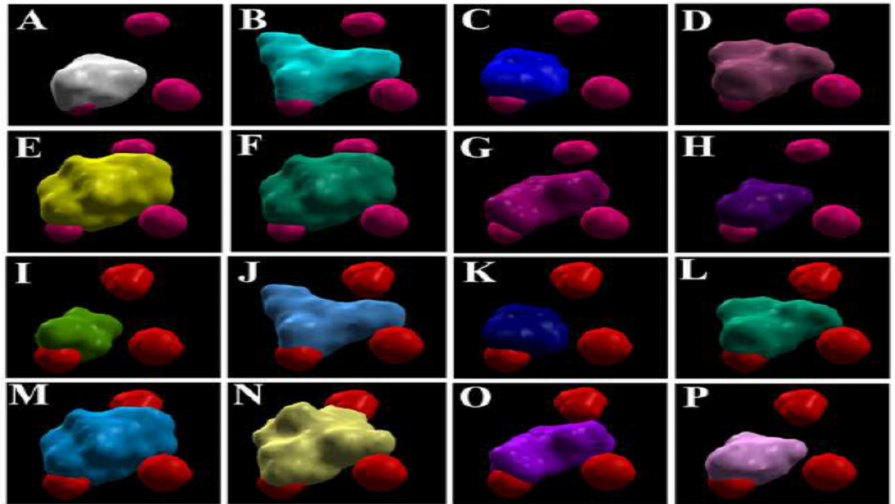
Figure 2. Overlapping electrostatic surfaces of metabolites and metals at the active site of Os DHAR. ( A ) AsA; ( B ) JA; ( C ) SA; ( D ) 5-HT; ( E ) GA3; ( F ) GSH; ( G ) IAA and ( H ) DHA with Mn 2+ ; and ( I ) AsA; ( J ) JA; ( K ) SA; ( L ) 5-HT; ( M ) GA3; ( N ) GSH; ( O ) IAA and ( P ) DHA with Al 3+ . The spherical purple and red spheres represent the surfaces of Al 3+ and Mn 2+ ions, respectively.